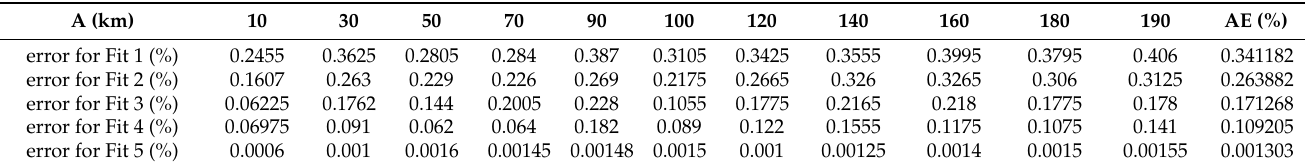
Table 10. LL-G fault prediction Table 6. LG fault prediction error utilizing line current signals.